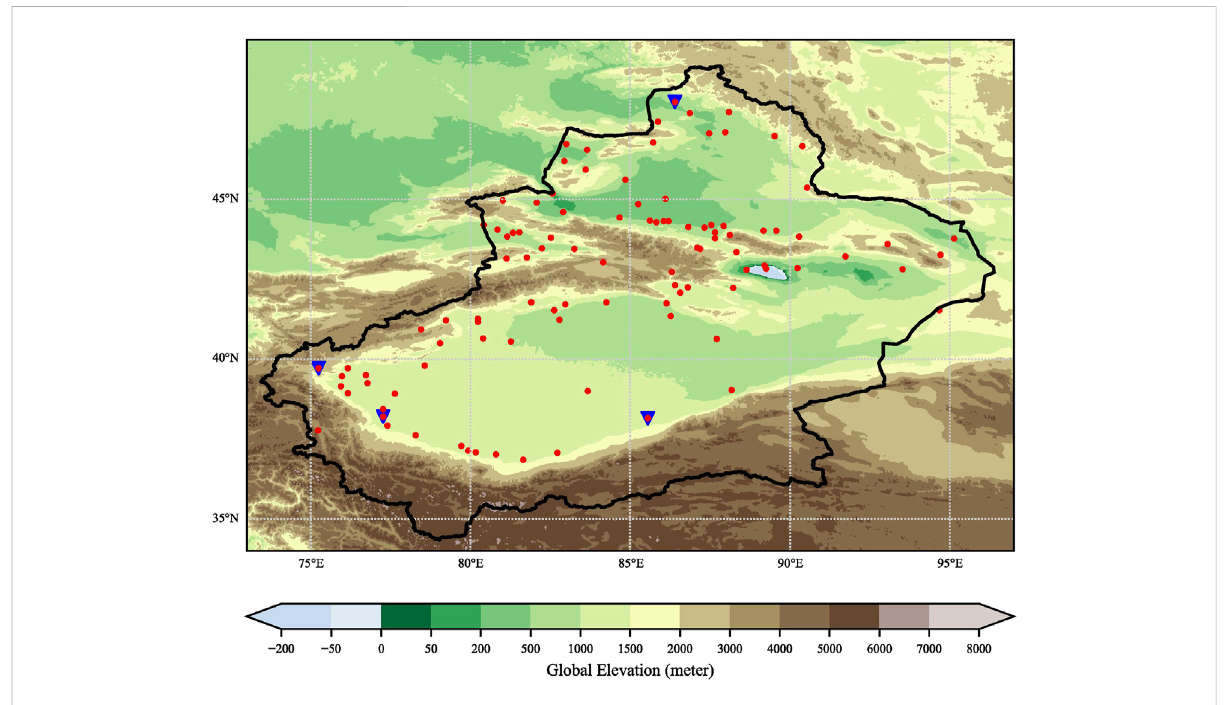
FIGURE 1 Orographic effects of the study area and the location of observation stations. The blue inverted triangles represent the example stations of X51053, X51705, X51815, and